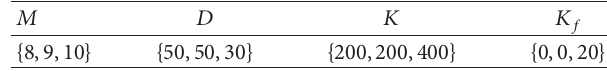
Table 2: Impedance